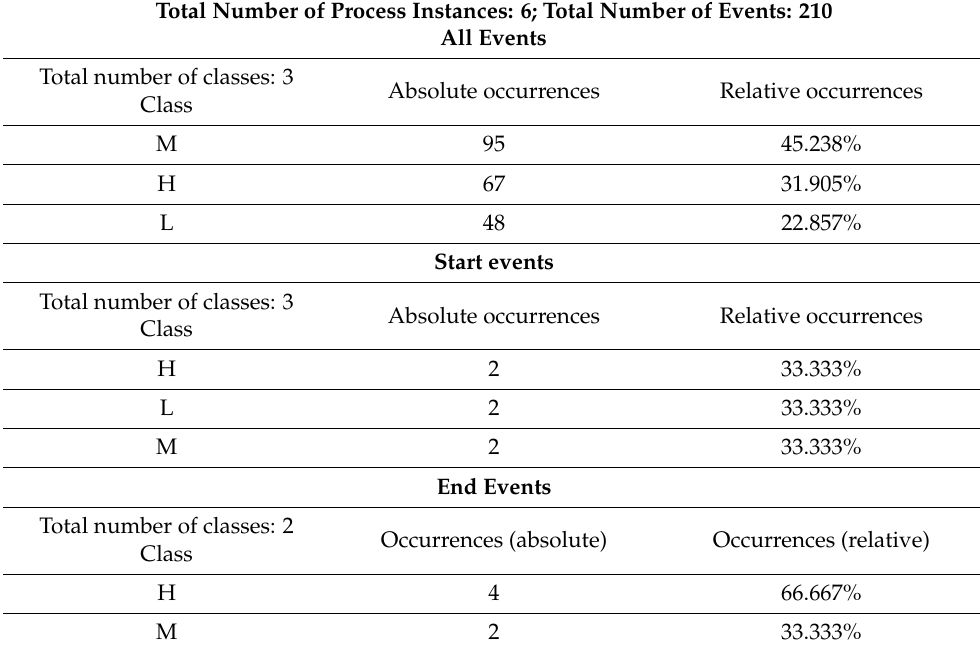
Table 2. Distribution of event classes in a log for students’